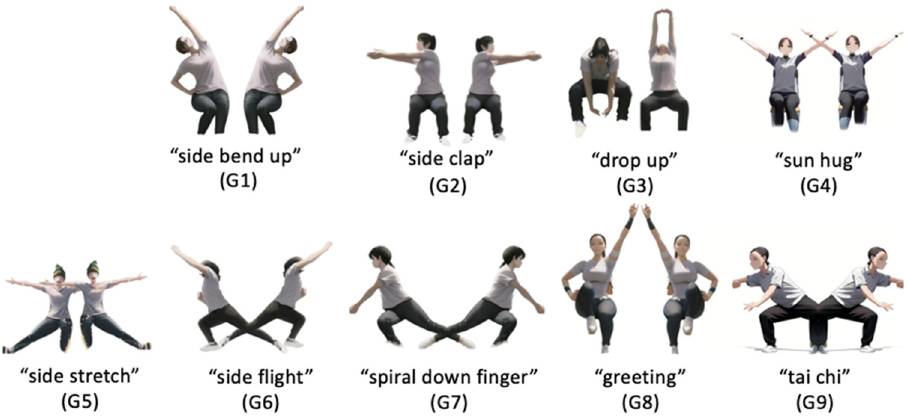
Figure 3. Yapa-PBGA Rehabilitation Posture Model.